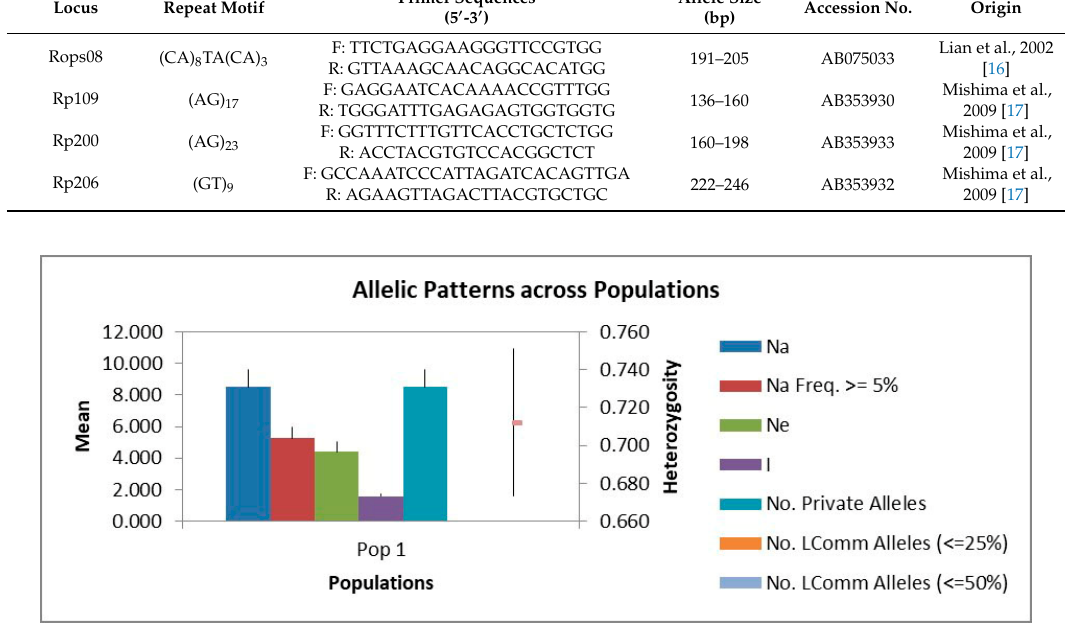
Figure 3. Mean values of polymorphism indices across 123 black locust cultivars. (Na: number of alleles; Na Freq. ≥ 5%: number of alleles with a frequency ≥ 5%; Ne: number of effective alleles; I: Shannon’s Information Index; No. Private Alleles: number of alleles unique to a single sub-group.). Table 4. Indices of polymorphism obtained for 123 black locust cultivars with 12 SSR markers .